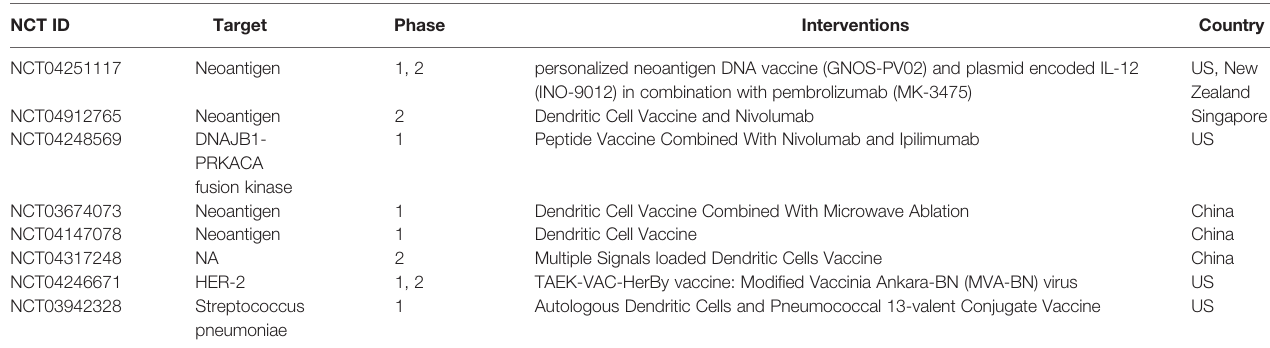
TABLE 3 | Clinical trials of therapeutic vaccines for HCC the last three